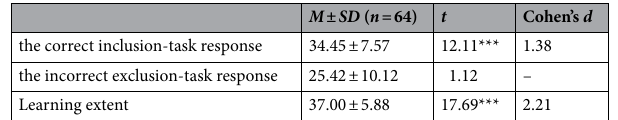
Table 1. Indexes of generation tasks ( M ± SD